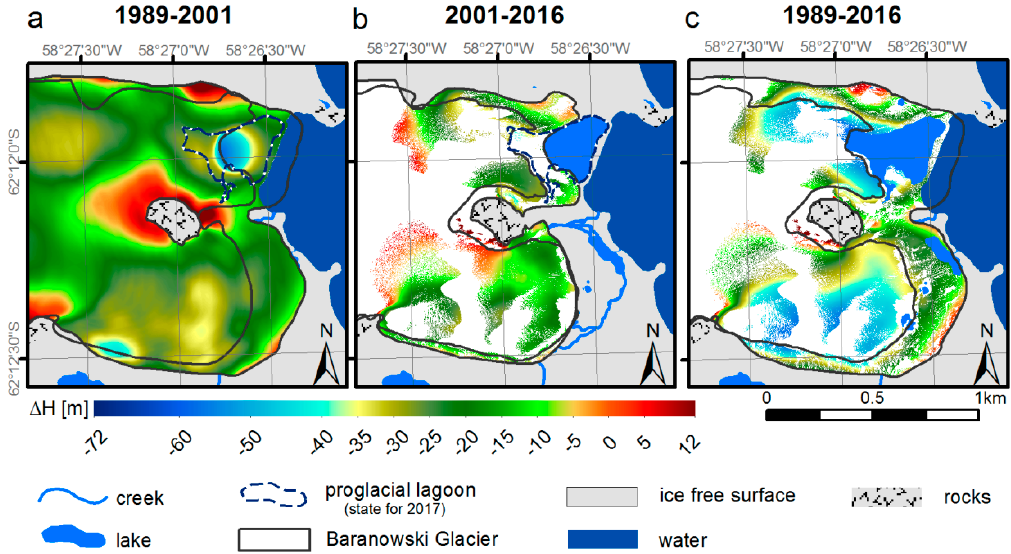
Figure 8. Ice surface elevation differences between ( a ) 1989 and 2001, ( b ) 2001 and 2016, and ( c ) 1989 and 2016. Reference system: WGS 1984, UTM zone 21S, and geoid EGM96.